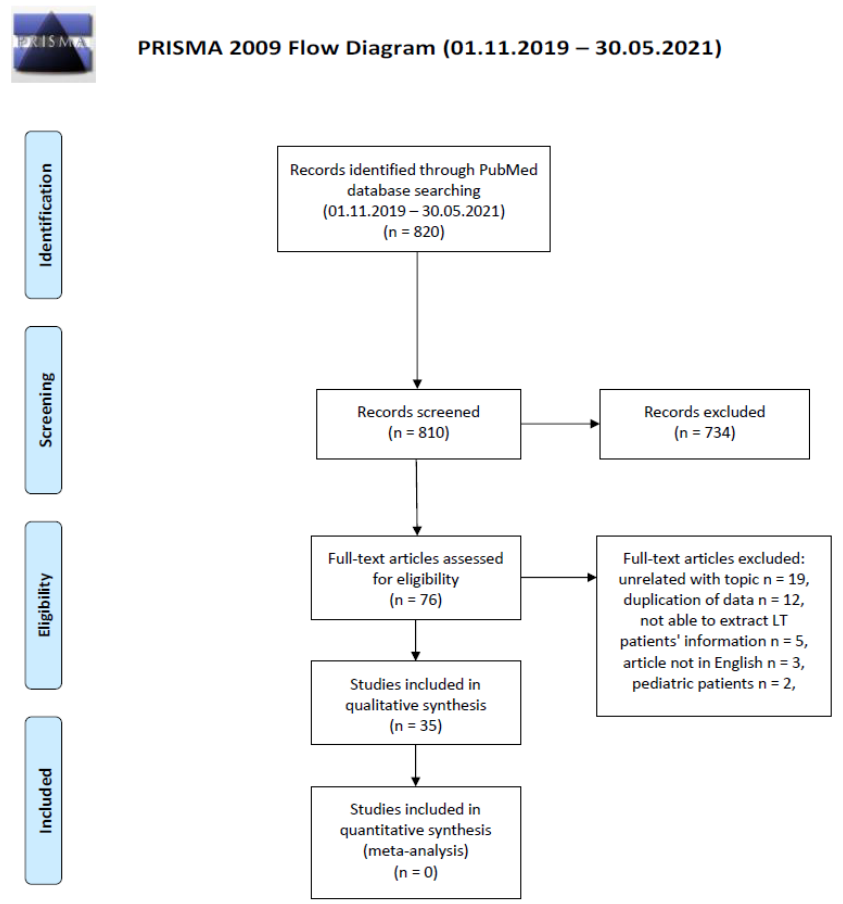
Figure 1. Flow diagram of the systematic literature search according to the PRISMA statement.